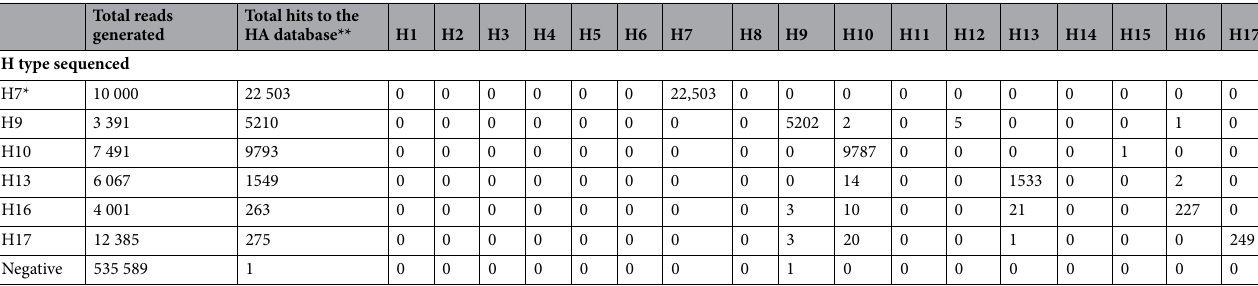
Table 2. MinION generated reads mapping to the Australia AIV HA database** to enable real-time subtype level classification of reads. *H7 was subsampled to 10 000 reads from the total generated reads. **Refer to Table 1 for